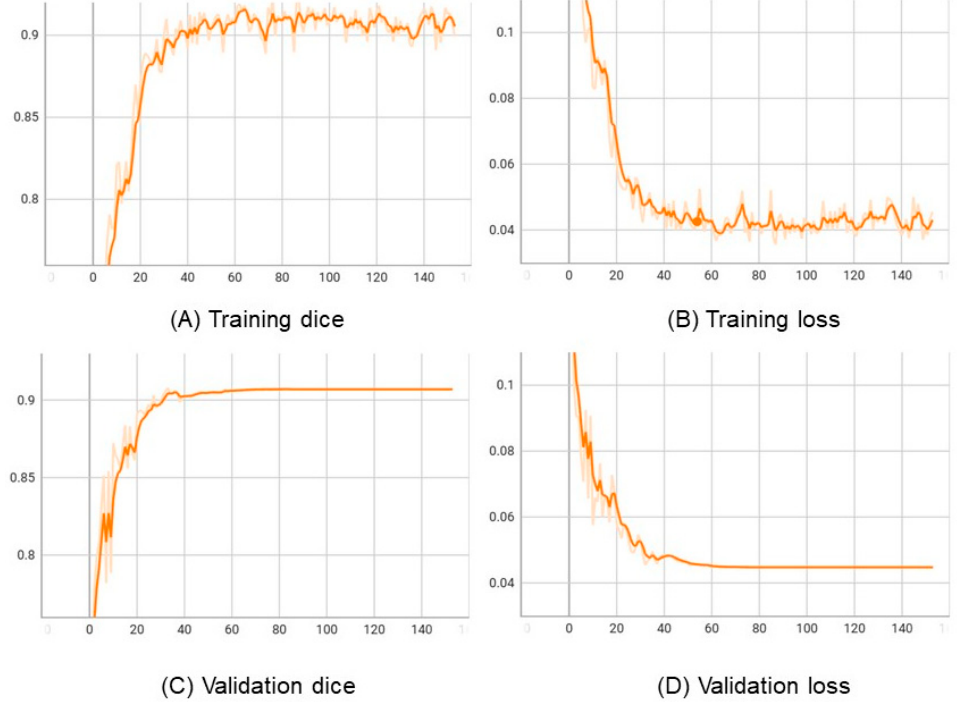
Figure 5. The learning curves of the VLSM-Net in LiTS: horizontal axes represents epochs. ( A ) Vertical axis represents training dice. ( B ) Vertical axis represents training loss. ( C ) Vertical axis represents validation dice. ( D ) Vertical axis represents validation loss.